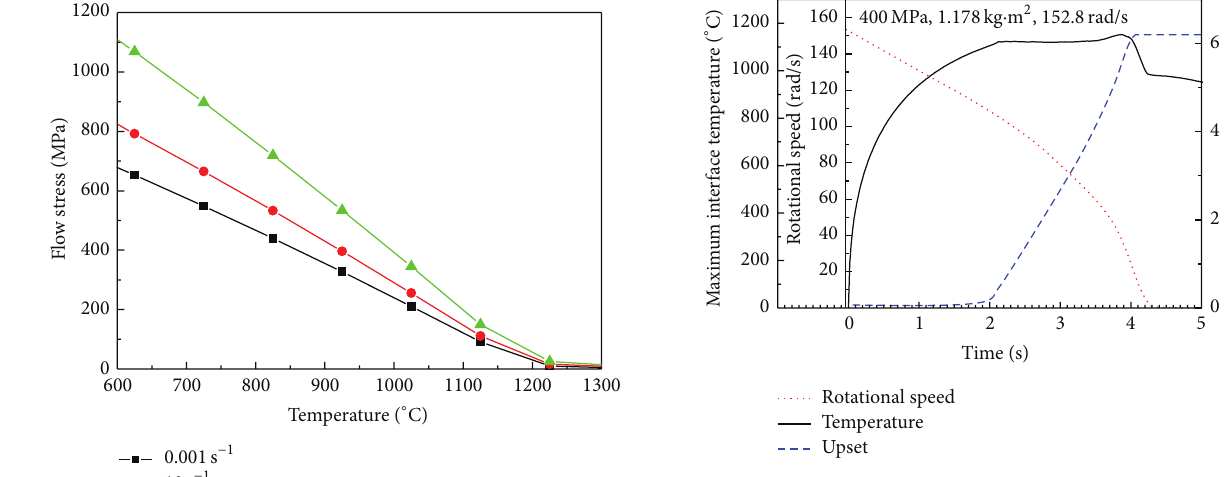
Figure 3: Variations of maximum interface temperature, rotational speed, and upset with welding time.